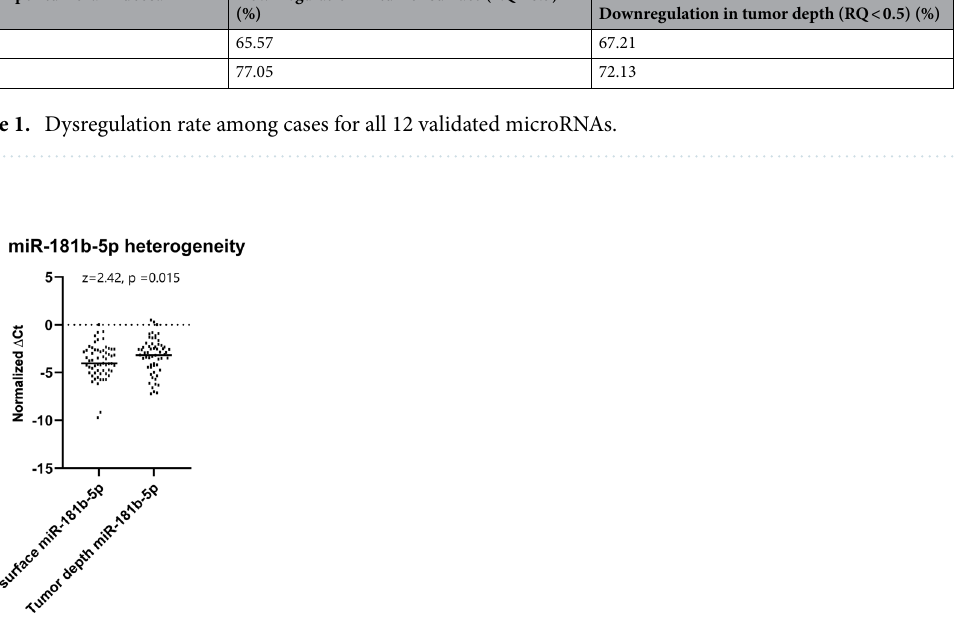
Figure 2. Significant difference in expression levels of miR-181b-5p between tumor surface and depth (pairwise comparison, Wilcoxon signed-rank test, z = 2.42, p =